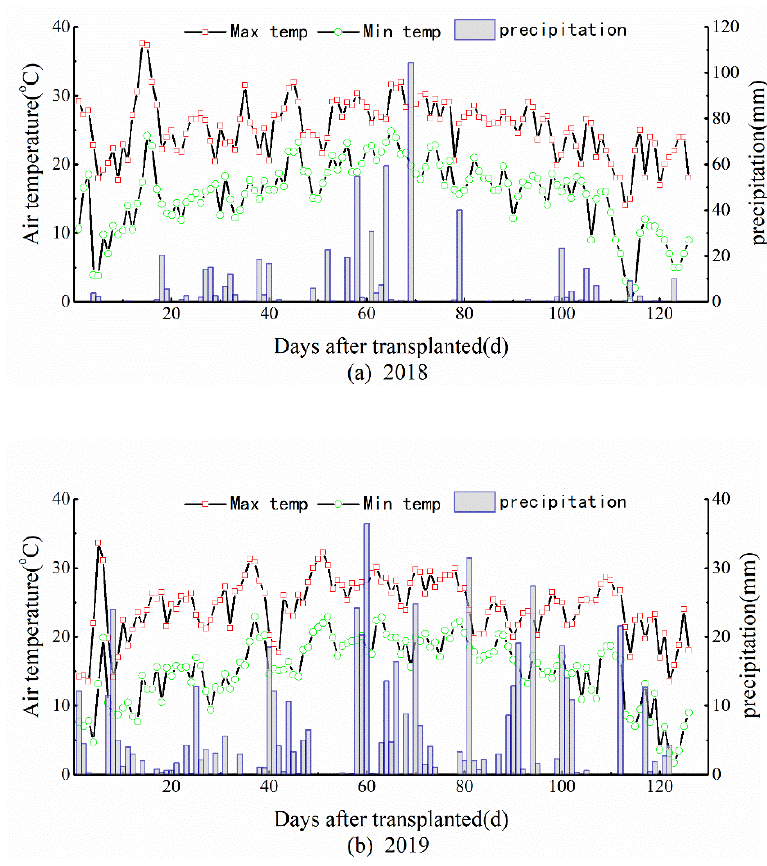
Figure 1. Changes in maximum and minimum air temperature and precipitation in ( a ) 2018 and ( b ) 2019.